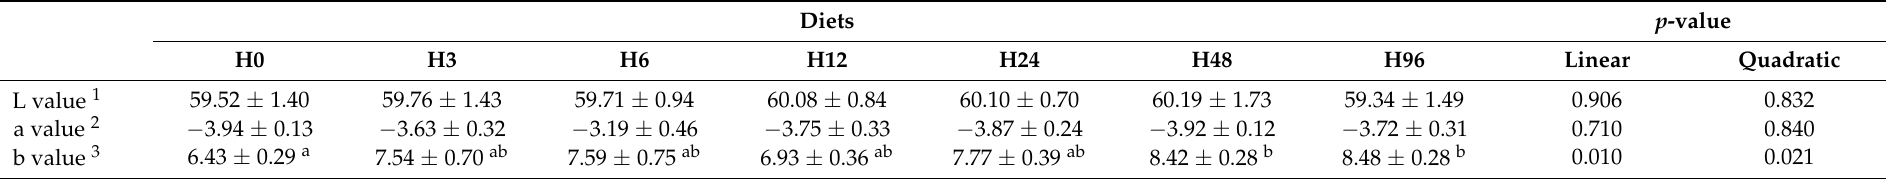
Table 9. Effect of dietary histamine content on the color of the dorsal muscle of the hybrid